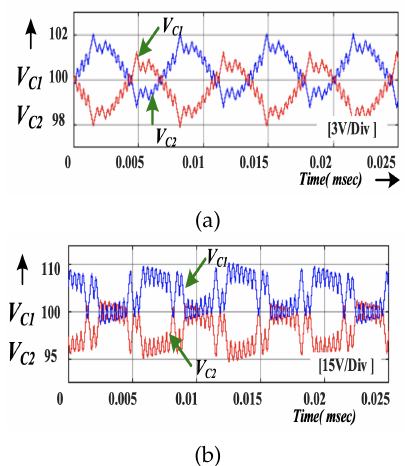
Fig. 7. Simulation results of NPC-MLI DC-link Capacitors voltage V C1 and V C2 at M a = 0.9: (a) Proposed TST and